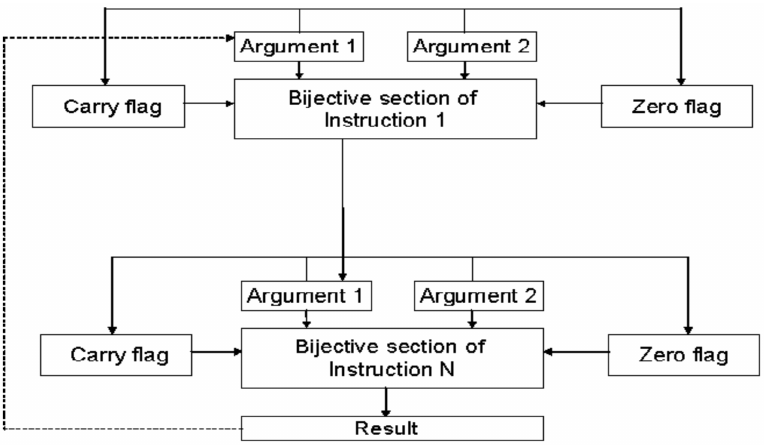
Figure 3. Architecture of the bijective block.